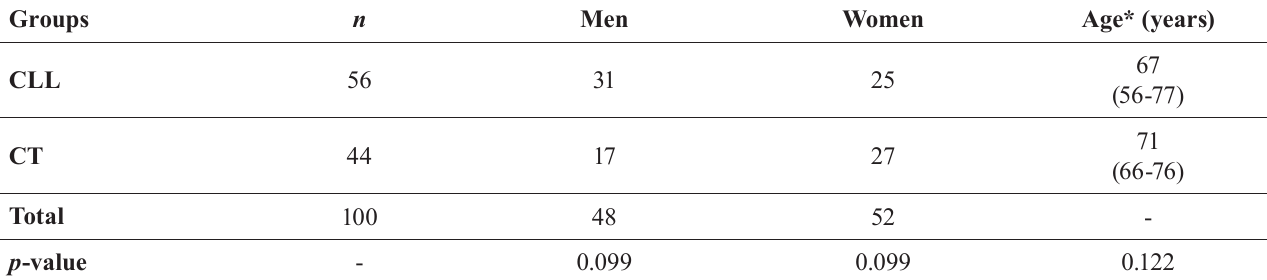
CLL: Chronic Lymphocytic Leukemia; CT: Controls. *Median. Statistical test: Normality, Shapiro-Wilk; Comparison of two groups,